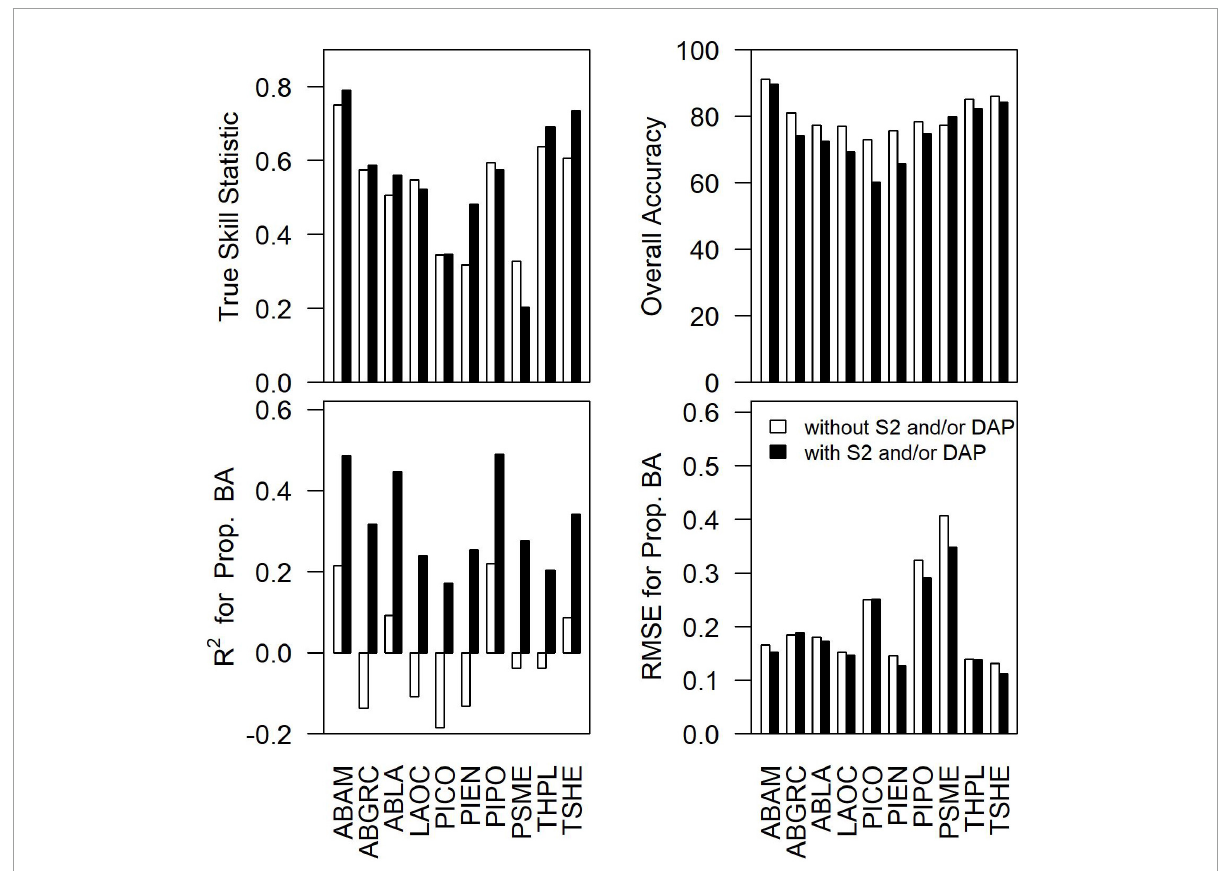
FIGURE3 The difference in true skill statistic, overall accuracy, R 2 for proportional basal area, and RMSE for the proportional basal area between the best performing species-level models with vs. without DAP and/or Sentinel-2 data. Species abbreviations can be found in Table 1